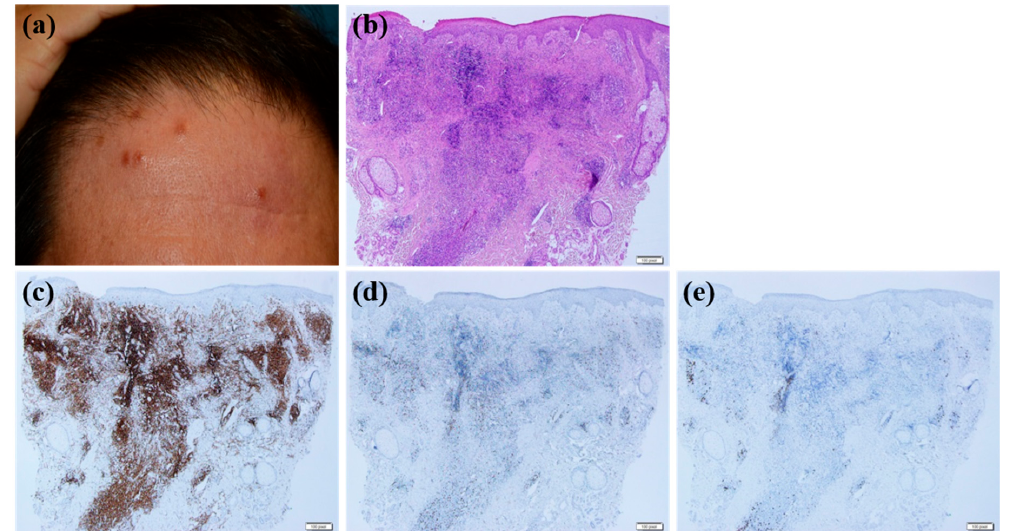
Figure 5. The clinicopathological features of drug-induced cutaneous lymphoid hyperplasia. ( a ) Multiple erythematous papules were observed 1 month after taking new drugs. ( b ) Histopathological examination revealed diffuse lymphocytic infiltration in the whole dermis (hematoxylin and eosin stain; magnification, ×40). Lymphocytes were intensely stained with CD4 ( c ), whereas fewer than 10% of lymphocytes showed positive reactivity for CD8 ( d ) and CD20 ( e ) (×40).